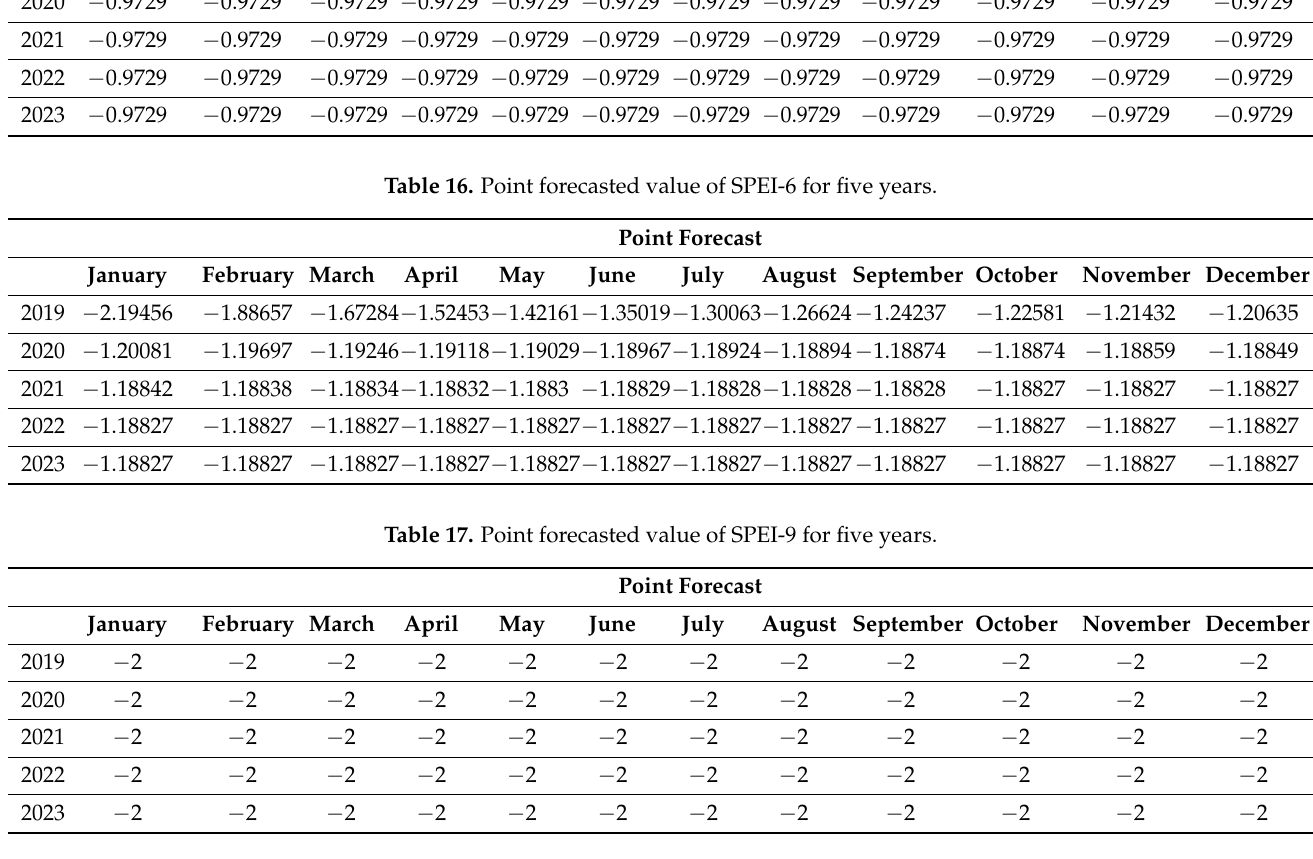
Table 18. Point forecasted value of SPEI-12 for five years. Point Forecast